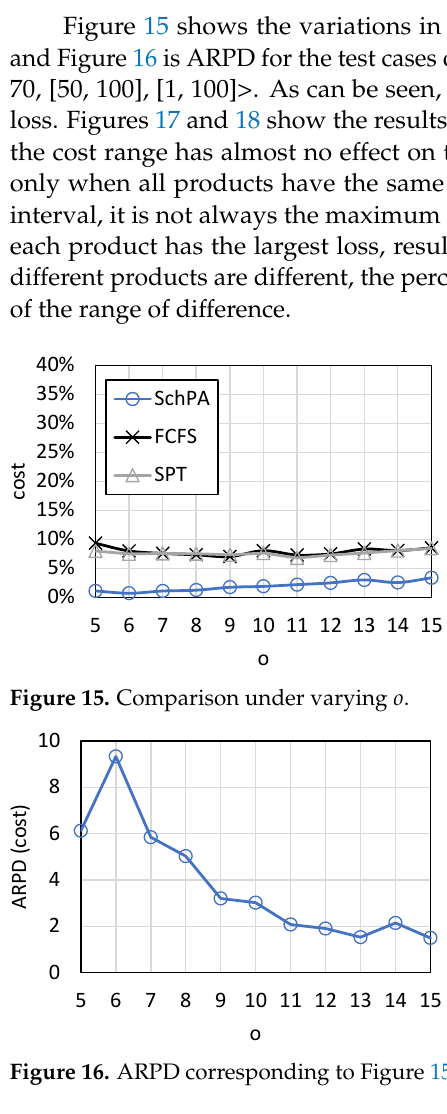
Figure 14. ARPD corresponding to Figure 13.